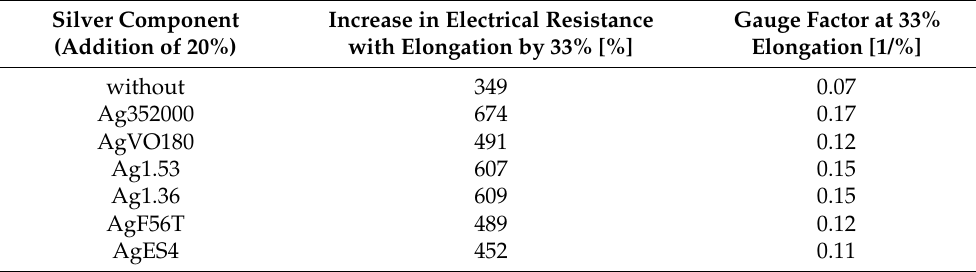
Table 4. Increase in electrical resistance due to 33% elongation of monofilament as a function of added silver